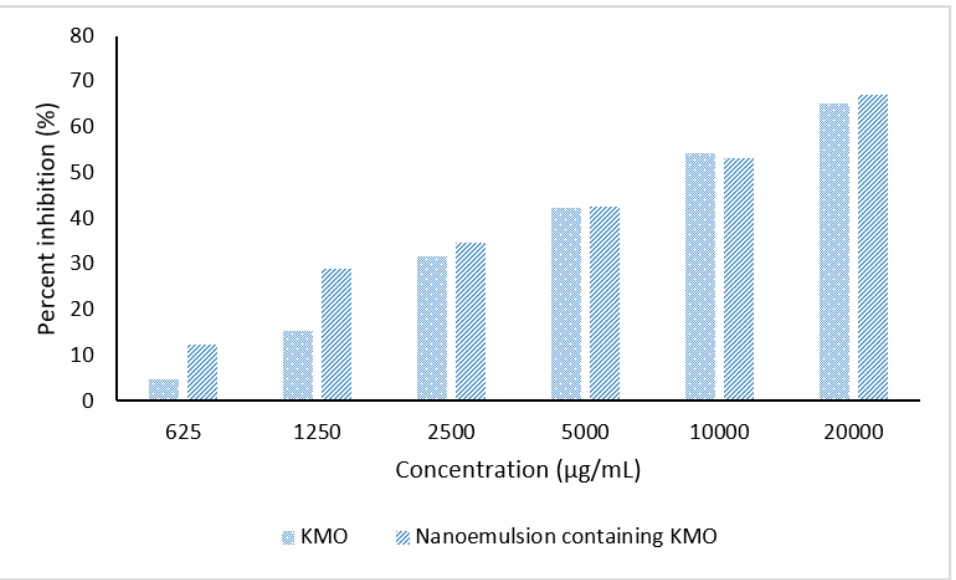
Figure 9. Inhibitory activity of tyrosinase enzyme by KMO and optimized nanoemulsion containing KMO.